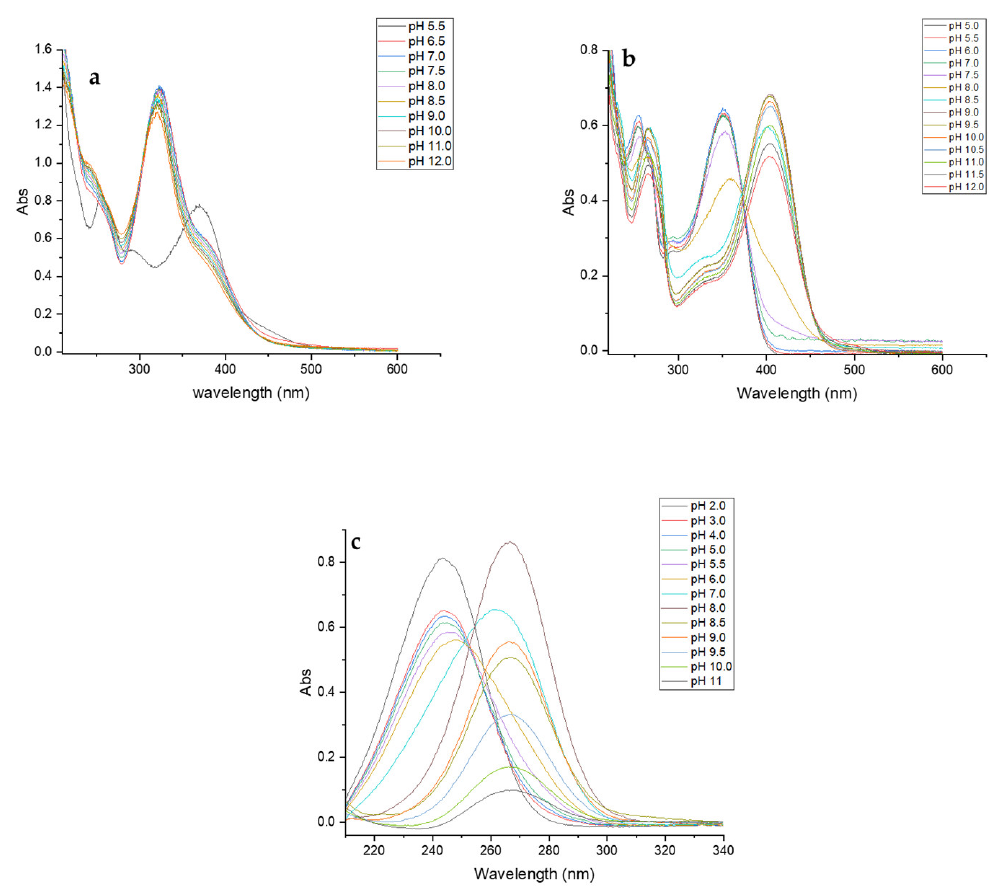
Figure A2. UV-vis spectra recorded for quercetin 0.025 mM ( a ), luteolin 0.010 mM ( b ) and L -ascorbic acid 0.040 mM ( c ), at 37 °C and in 0.16 M NaCl. Table A1. Acidic constants of quercetin (Que), luteolin (Lut) and L -ascorbic acid (A.A.) from the literature. The uncertainties on the log values represent σ.